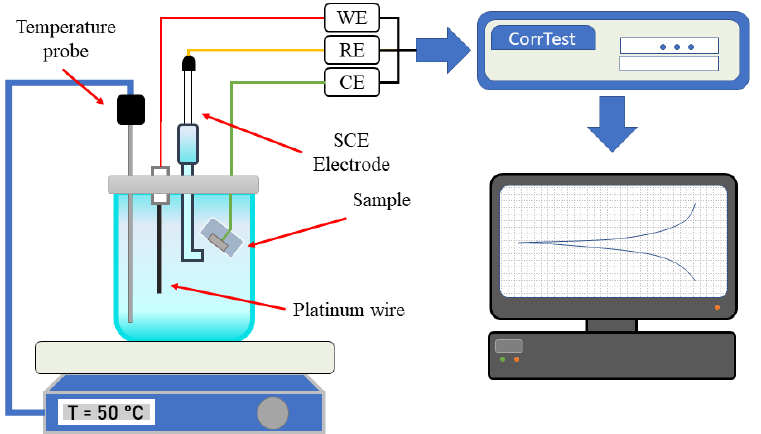
Figure 13. Electrochemical workstation for the evaluation of the hydrogen evolution reaction on Ni-based electrodes.